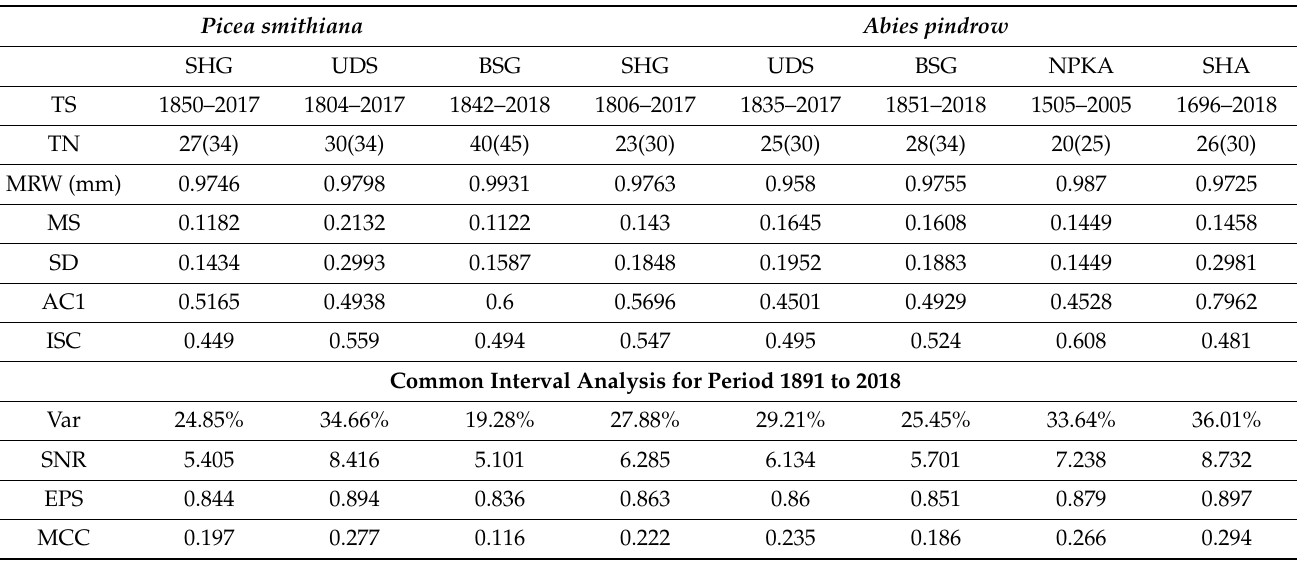
Table 3. Statistical characteristics of spruce and fir standard chronologies at five sites (SHG, UDS, BSG.NPKA, SHA) of the northern area of